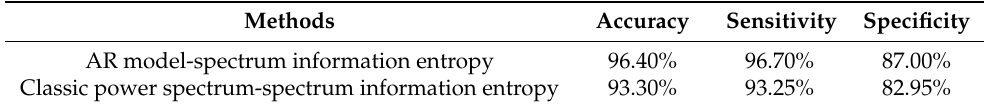
Table 1. Comparison of consistency between the two